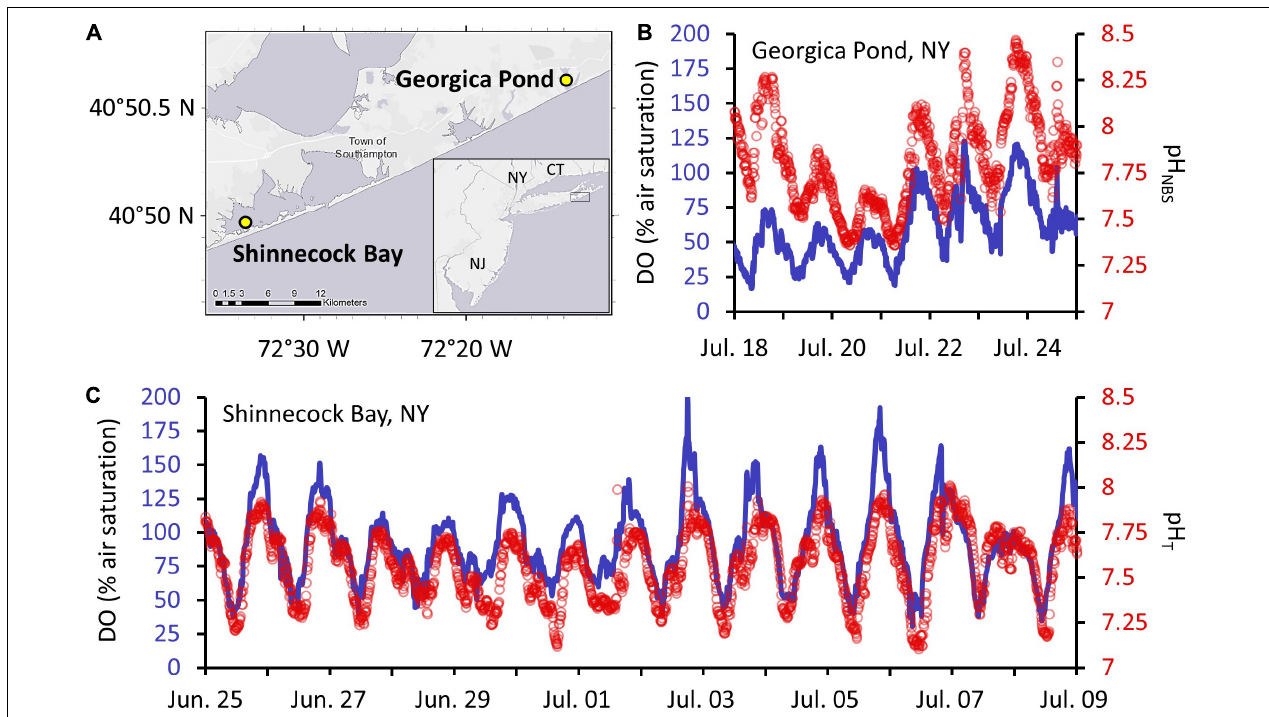
FIGURE 1 | Daily fluctuations of dissolved oxygen (DO; line) and pH (circles) at two sites hosting ovigerous female blue crabs on Long Island, NY. (A) Locations of the two sites; (B) DO and pH fluctuations of Georgica Pond (temperature: 27.7 ± 1.1 ◦ C) a temporarily open estuary, and the site of one of the most robust blue crab fisheries in NY; (C) DO and pH fluctuations of Shinnecock Bay (temperature: 25.1 ± 1.2 ◦ C), the location where all ovigerous female blue crabs were sourced from for larval